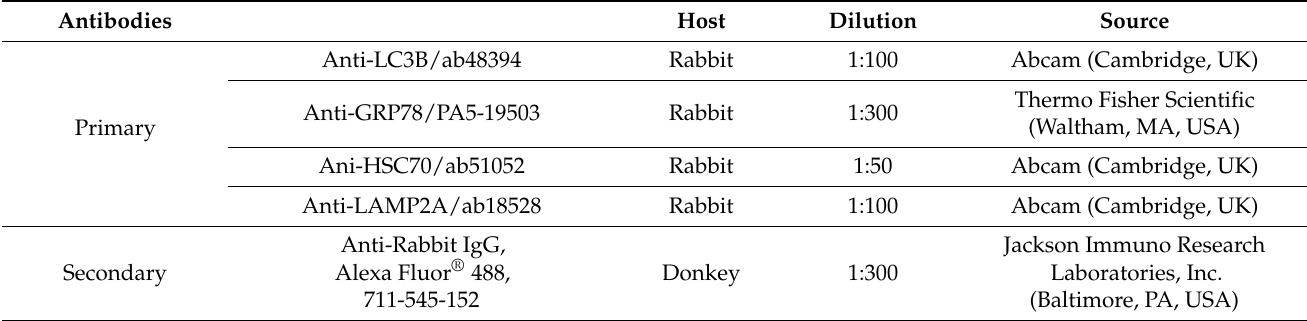
Table 1. Antibodies used for